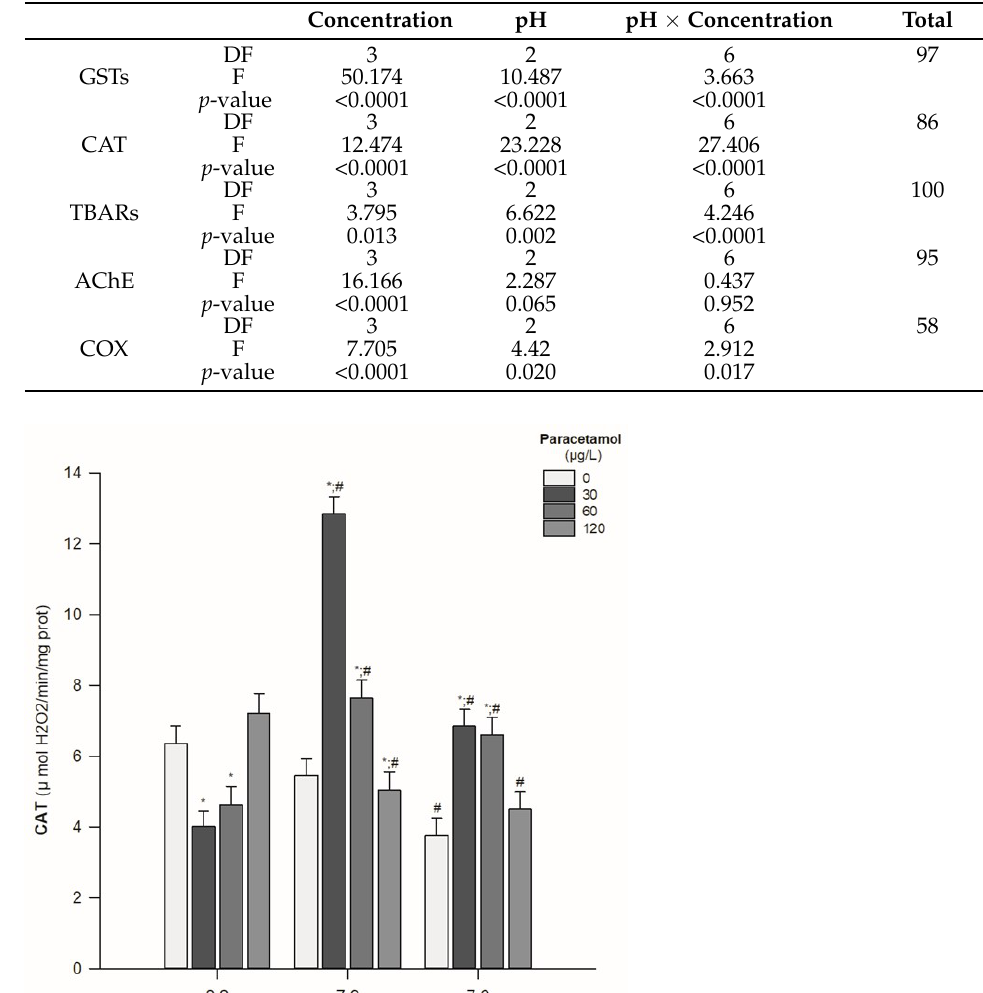
Table 2. Two-way ANOVA results testing the effects of drug concentration and pH values on biochemical parameters of Hediste diversicolor exposed for 28 days to 0, 30, 60, and 120 µg/L of PAR at control pH (8.2), intermediate pH (7.9), and low pH (7.6).